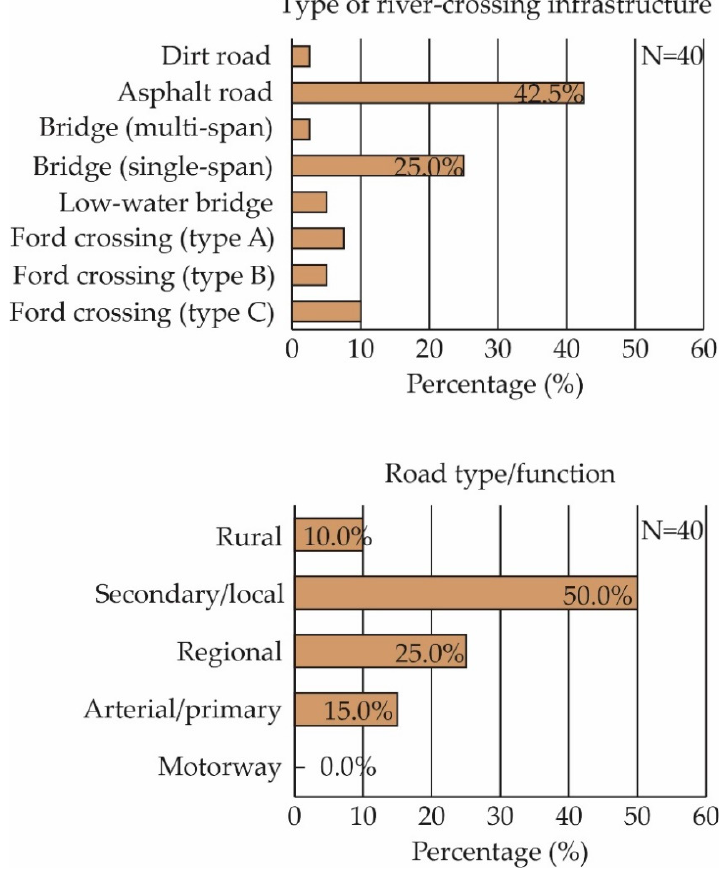
Figure 7. Distribution of cases with respect to road function and road type. Please note that ford crossings are divided in vented with box culverts (Type A), unvented with improved surface (type B) and unvented without an improved surface (type C).